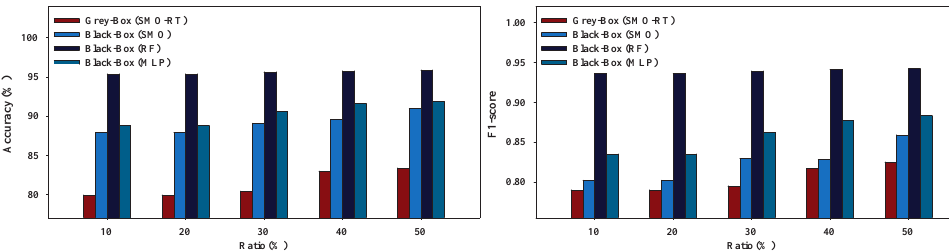
Figure 10. Box-plot with performance evaluation of Grey-Box and Black-Box models for EduDataAB dataset.